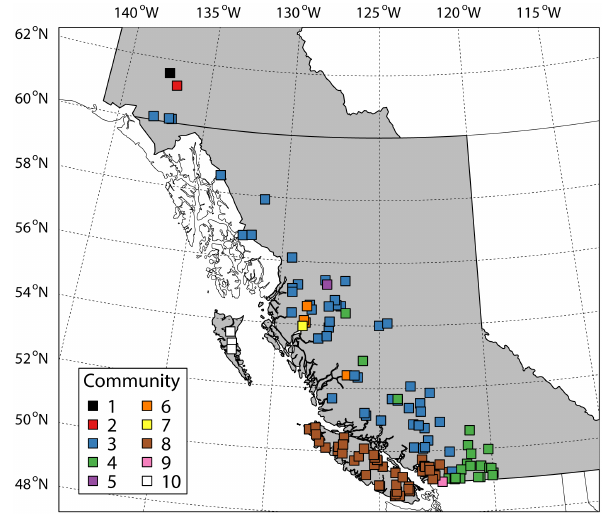
Figure 8. Streamflow station map coloured according to commu- nity membership. The communities were identified with the edge betweenness algorithm (Girvan and Newman, 2002; Newman and Girvan,